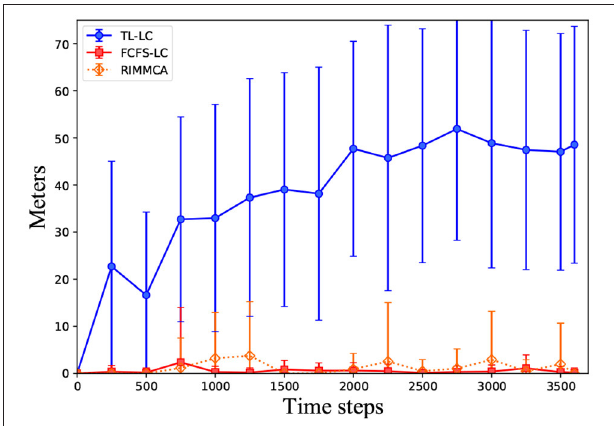
FIGURE 8 | Average queuing length results with standard deviation of four different in-intersection obstruction scenarios (20 runs per